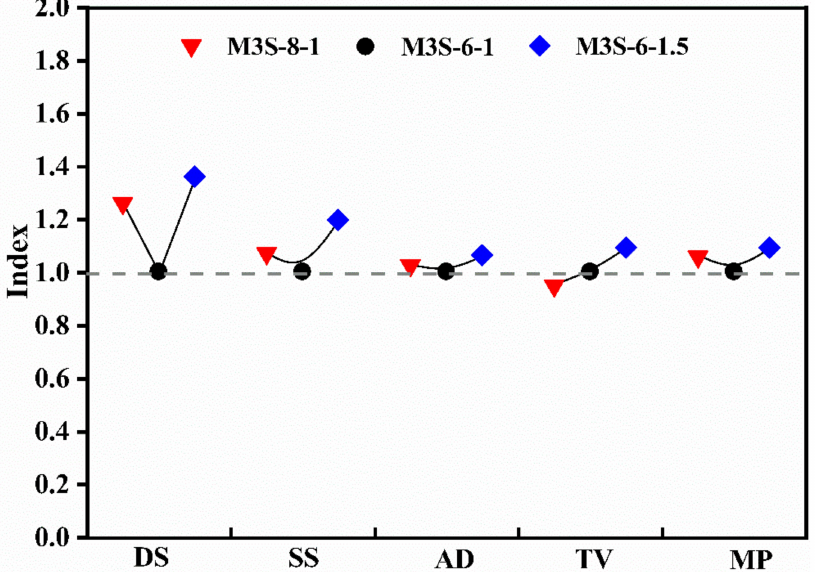
Figure 18. Influences of activator concentration and modulus on the drying shrinkage and pore structure characteristic parameters of alkali-activated slag containing 30%